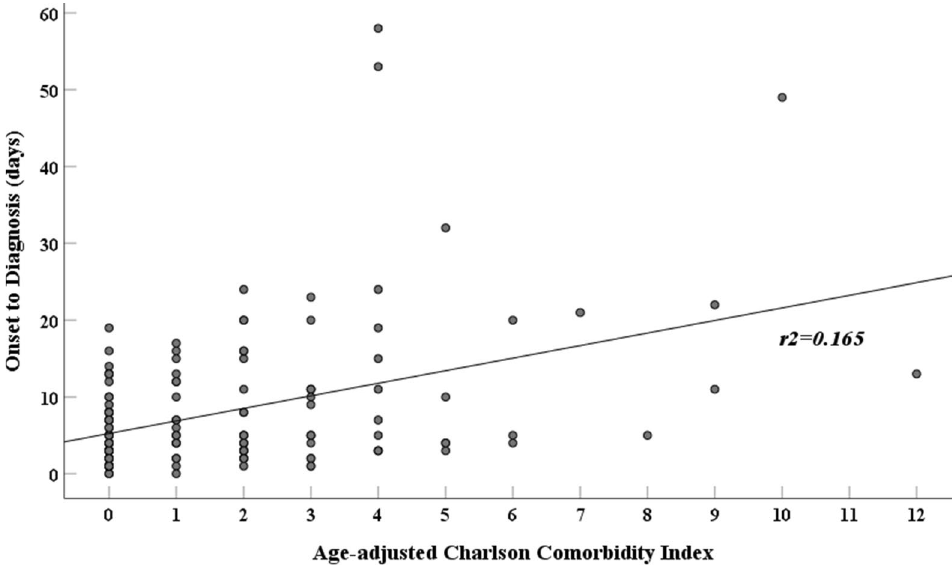
Figure 1. Correlation between age-adjusted Chralson Comorbidity Index score and duration from symptom onset to diagnosis of Guillain–Barre